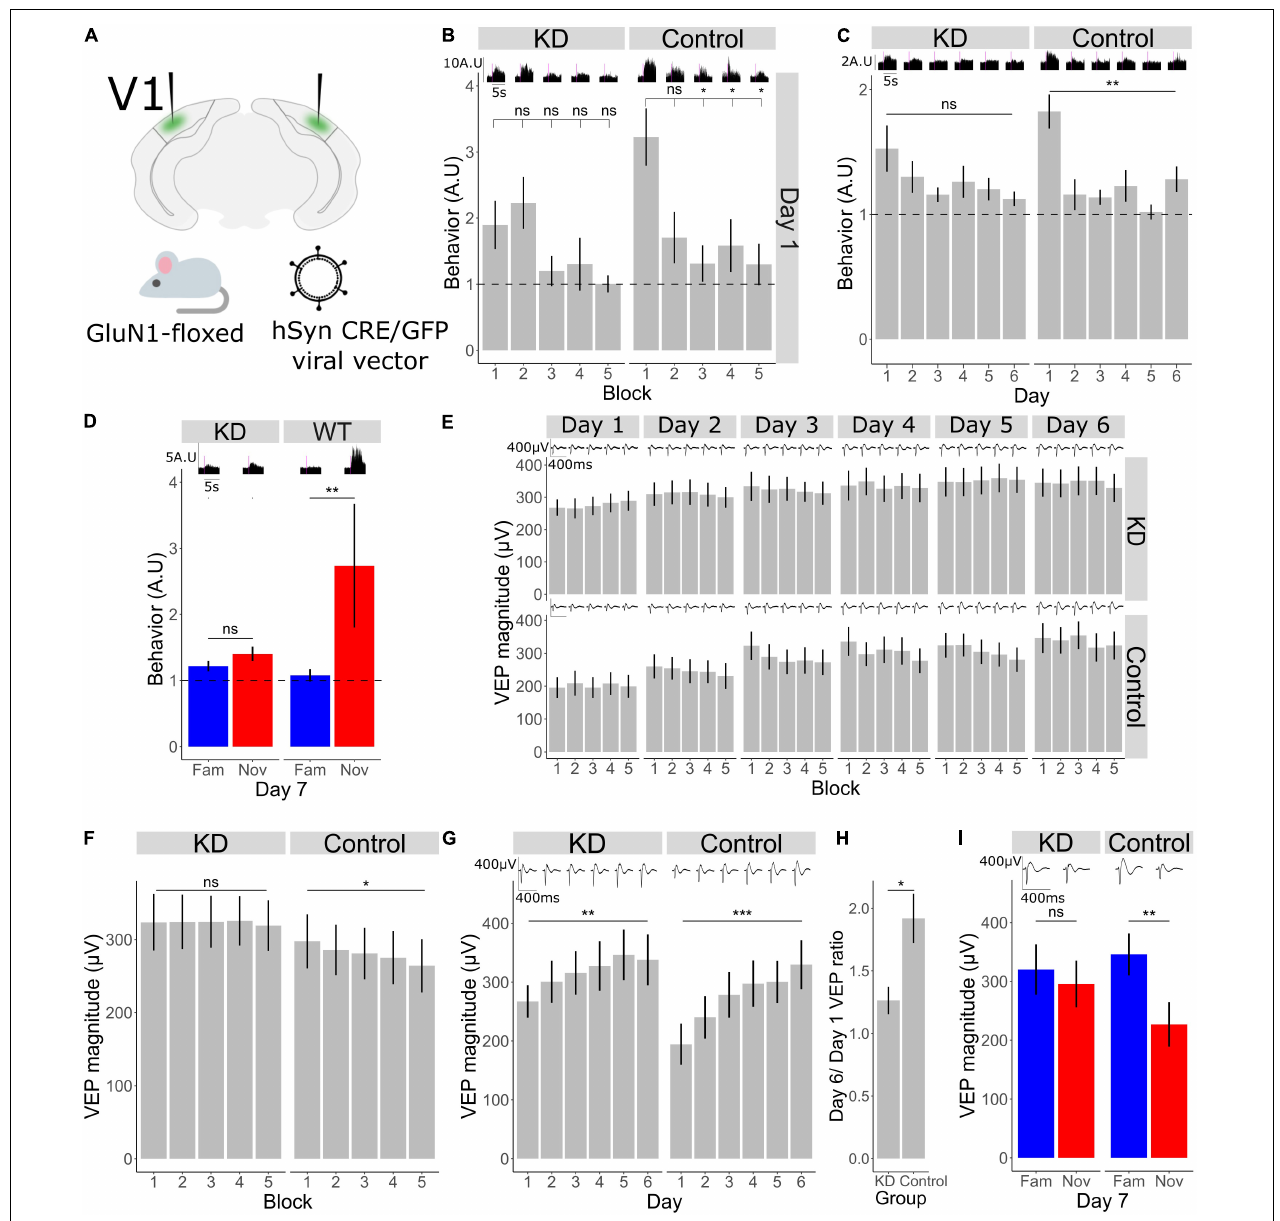
FIGURE 3 | Bidirectional plasticity occurring in V1 during short- and long-term habituation require NMDA receptors in V1. (A) Schematic of the experimental set-up in which a Cre recombinase was locally expressed bilaterally in binocular V1 using an AAV viral vector to knockdown the mandatory GluN1 subunit of the NMDA receptor in GluN1-floxed mice. (B) Comparison of behavior across blocks for KD group ( n = 11). Friedman test χ 2 (4) = 4.7, p = 0.3. Post-hoc analysis of individual comparisons of blocks 1–2: p = 0.8, blocks 1–3: p = 0.5, blocks 1–4: p = 0.3, blocks 1–5: p = 0.1. Comparison of behavior across blocks for WT group ( n = 11). Friedman test χ 2 (4) = 10.8, p = 0.03. Post-hoc analysis of individual comparisons of blocks 1–2: p = 0.1, blocks 1–3: p = 0.02, blocks 1–4: p = 0.02, blocks 1–5: p = 0.02. FDR correction for multiple comparisons. (C) Behavioral change over days 1–6 in KD group ( n = 11), Freidman test χ 2 (5) = 5.9, p = 0.3. In WT group ( n = 11), Freidman test χ 2 (5) = 21.6, p = 0.001. FDR correction for multiple comparisons. (D) Behavioral response to familiar and novel. Wilcoxon signed-rank test fam vs. nov in KD group: p = 0.2, in WT group: p = 0.009. FDR correction for multiple comparisons. (E) VEP magnitude change from block 1 to block 5 for day 1 to day 6 ( n = 11 for each group). (F) VEP potential magnitude averaged over day 1–6. Comparison over blocks for KD group, Friedman test χ 2 (4) = 0.7, p = 0.9 ( n = 11). Comparison over blocks for WT group, Friedman test χ 2 (4) = 12.1, p = 0.03 ( n = 11). FDR correction for multiple comparisons. (G) VEP magnitude across days 1–6 in knock-down (KD) and wild-type (WT groups). Friedman test for KD group: χ 2 (5) = 15.4, p = 0.008 ( n = 11). Friedman test for WT group: χ 2 (5) = 36.5, p < 0.001 ( n = 11). FDR correction for multiple comparisons. (H) Ratio of day 6 VEP magnitude to day 1 VEP magnitude in KD and control group. Wilcoxon signed rank between groups: p = 0.04. (I) VEP magnitude response to familiar and novel, Wilcoxon signed-rank test fam vs. nov for KD group: p = 0.2, for WT group: p = 0.003 ( n = 11). FDR correction for multiple comparisons. Asterisks throughout denote significance (* p < 0.05, ** p < 0.01, *** p < 0.001) while ns denotes non-significant.